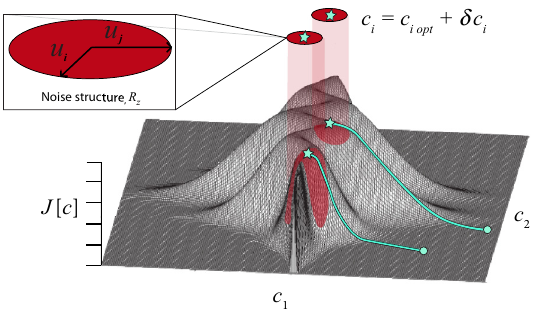
Fig. 6 Schematic indicating varying degrees of robustness FIG. 1. (Color online) Landscape description of robustness. Two of particular optimal control functions against noises. control search trajectories ascend to optimal control points, indicated Reproduced with permission from Ref. [60], (cid:13) C 2014 APS. by the stars. Average behavior of the stochastic noise can be specified by noise correlation functions (red ovals), with characteristic direc- is highly diverse in distinct spectral regimes of tions denoted by the eigenfunctions u i and u j . Robustness quality is determined by the degree of landscape curvature that overlaps with eigenfunction directions of the noise correlation function. Better robustness is given by the critical point at the middle of the landscape, which possesses shallow curvature compared to the critical point toward the foreground of the landscape.